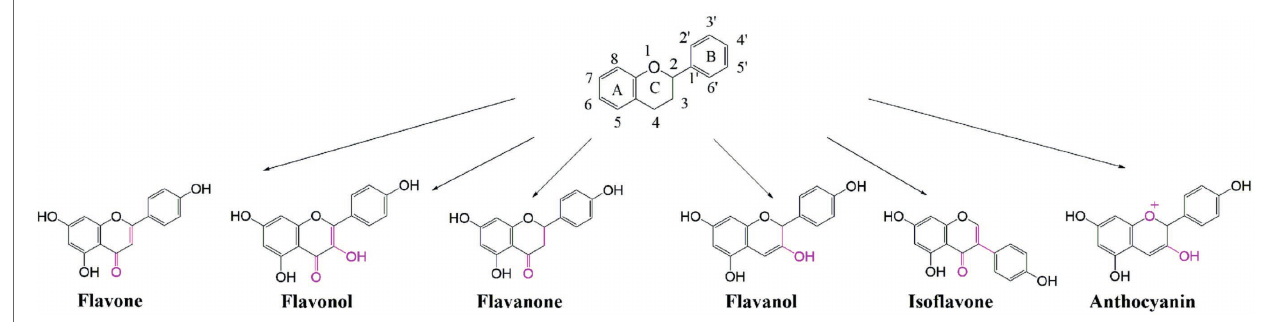
FIGURE 1 | Chemical structures and classification of flavonoids. The skeleton structure consists of A, B, and C rings with groups positions numbered. Flavonoids are sub-divided according to the hydroxylation pattern and conjugation between the aromatic rings (indicated in purple), and the chemical structures of six simple flavonoids are